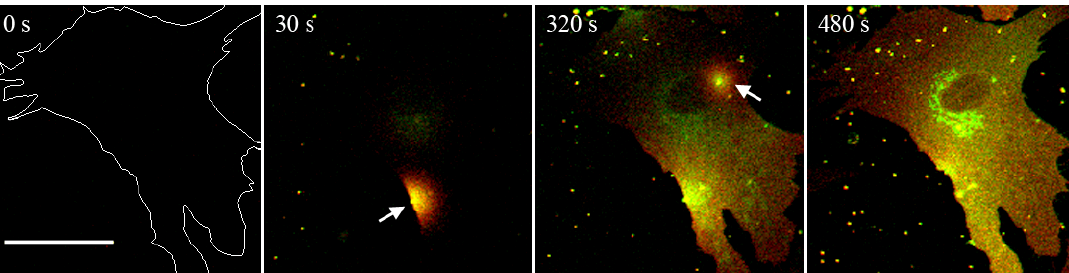
Figure 3. Plasma membrane staining with fusogenic